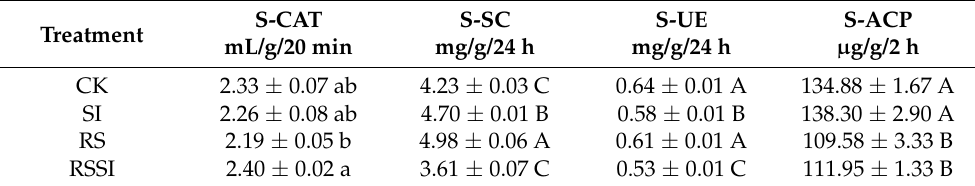
Table 1. Responses of rhizosphere soil physiochemical properties and enzymes under CK, SI, RS, and RSSI treatments. S-CAT S-SC S-UE S-ACP Treatment mL/g/20 min mg/g/24